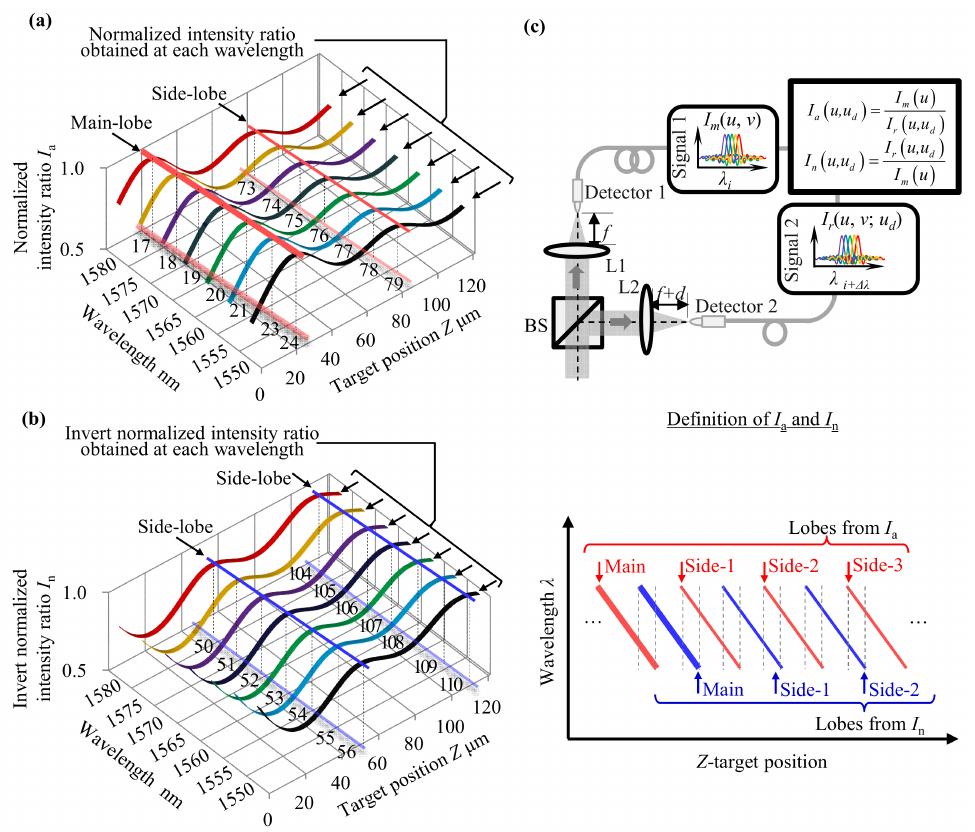
Figure 5. The main-lobe and the side-lobes in the axial response obtained by the dual-detector chromatic confocal probe with a mode-locked femtosecond laser source with target positions ranging from 0 to 120 µ m and a defocus d of 110 µ m. ( a ) Axial response of the normalized intensity ratio with shadow of the main-lobe and side-lobe and the corresponding target position values. ( b ) Axial response of the invert normalized intensity ratio with shadow of the side-lobes and the corresponding target position values. ( c ) The main-lobes and the side-lobes in the axial